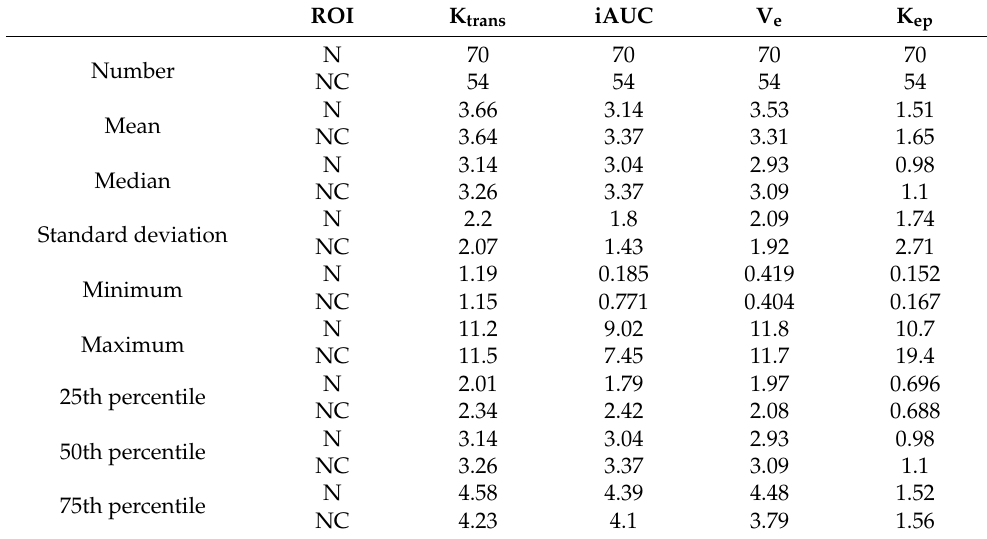
Table 1. Quantitative pharmacokinetic parameters in normal-to-muscle ratio of the negative control group categorized PIRADS 1 or 2 (NC) and normal-to-muscle ratio in the mirror area morphologically normal prostate tissue with detected organ confined unilateral lesions